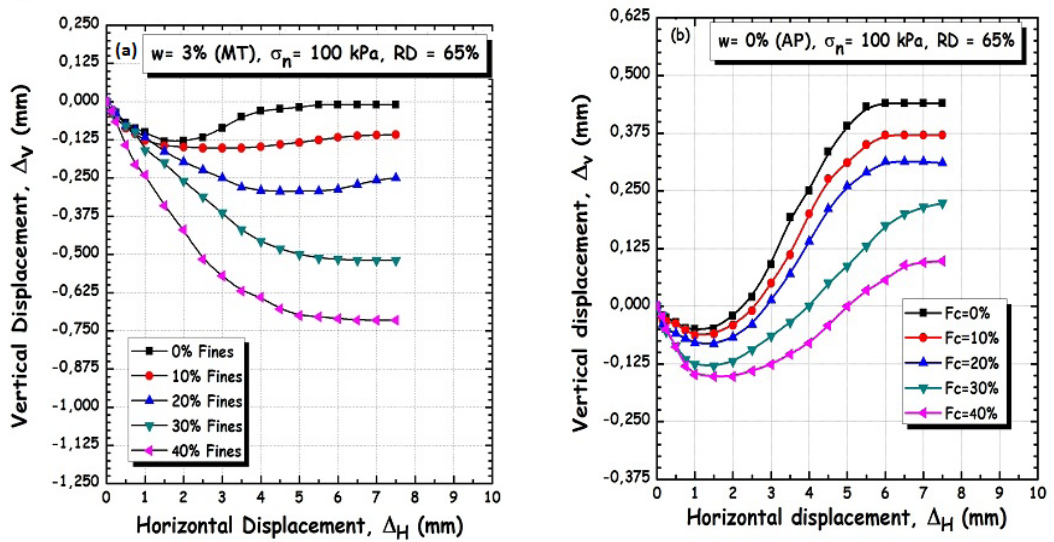
= 400 kPa): (a) variation of vertical n